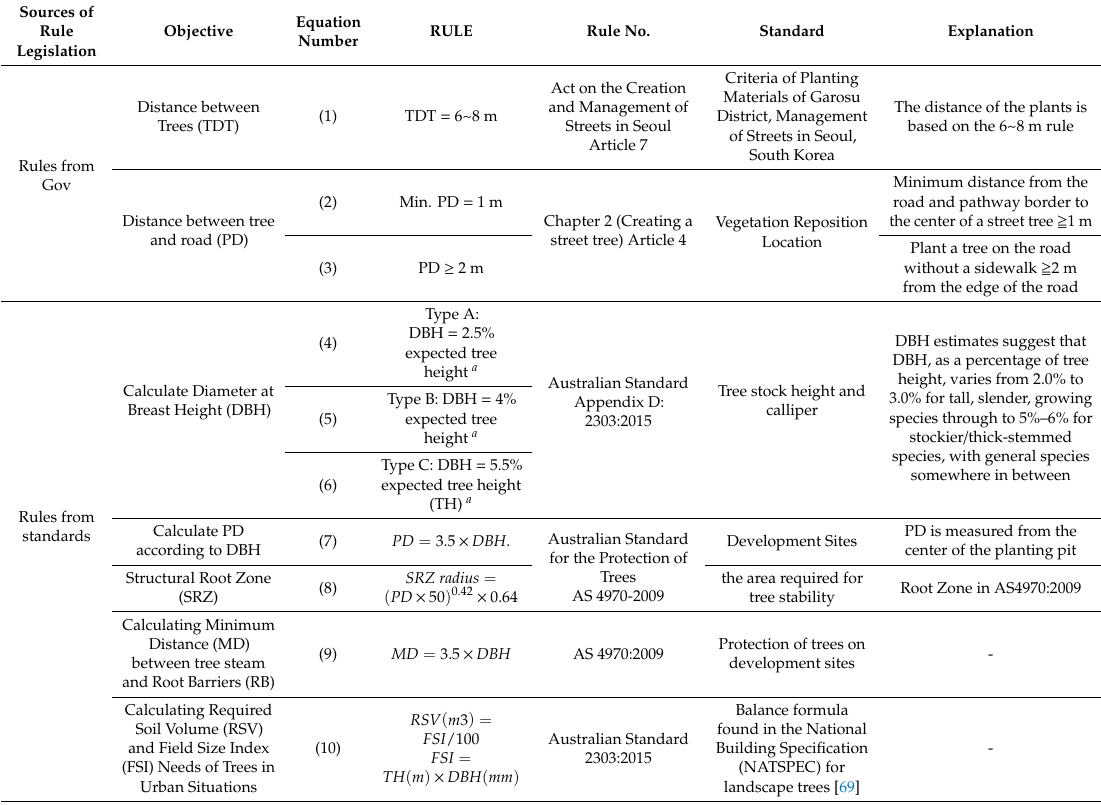
Table 1. Rules and standards related to urban street